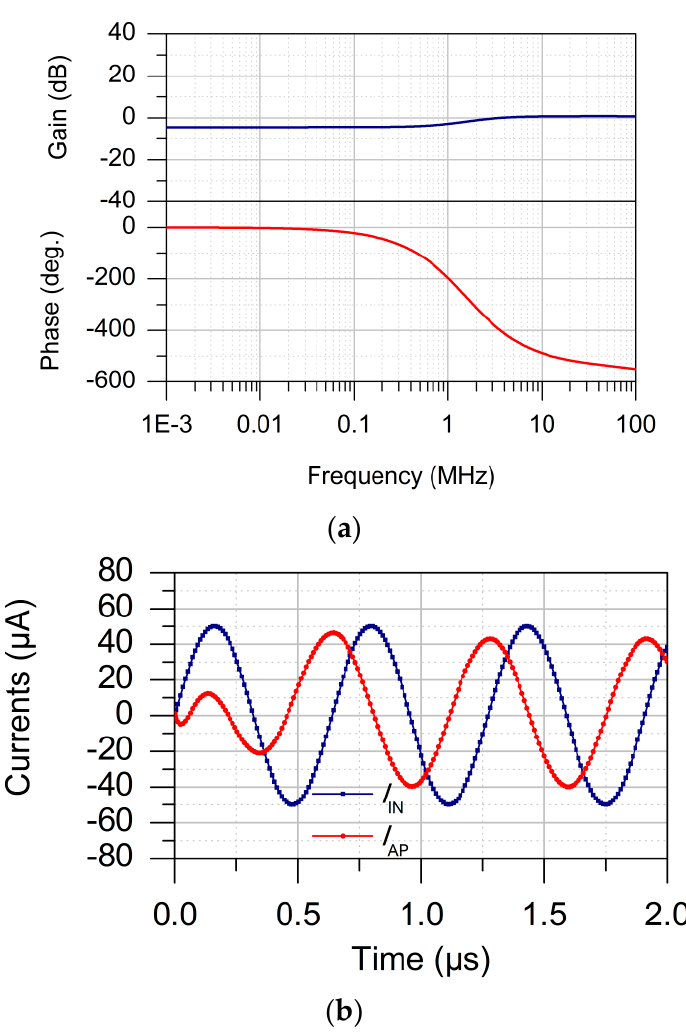
Figure 18. Third-order AP filter’s responses: ( a ) frequency responses of gain and phase; ( b ) transient response for differential input and output currents.